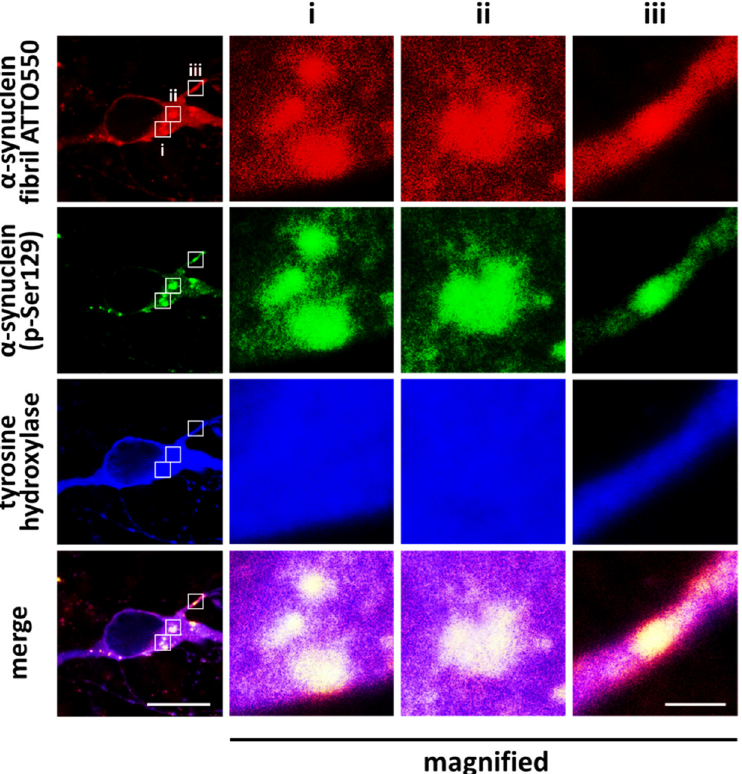
Figure 2. α -Synuclein Ser129 phosphorylation in cultured dopaminergic neurons. Exposure to exogenous α -synuclein fibrils induces the formation of phosphorylated α -synuclein-positive intracellular aggregates. Cells were exposed to ATTO550-labeled α -synuclein fibrils for 48 h. Scale bar = 10 μ m, and 1 μ m in magnified images of ROI i, ii, and iii. Images were originally obtained for this review.